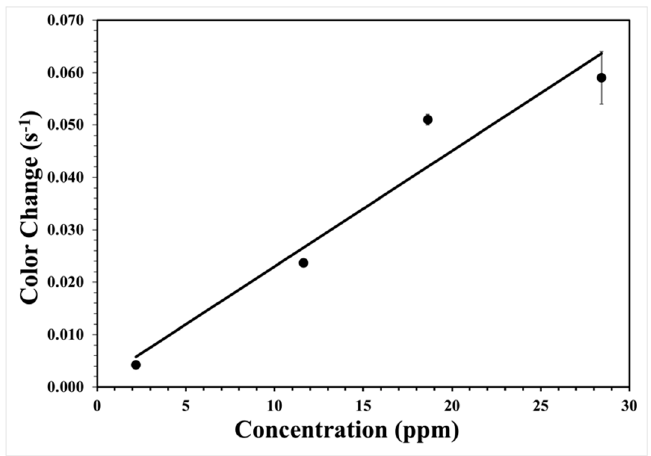
Figure 7. The phenomenological rate versus hydrogen peroxide concentration in